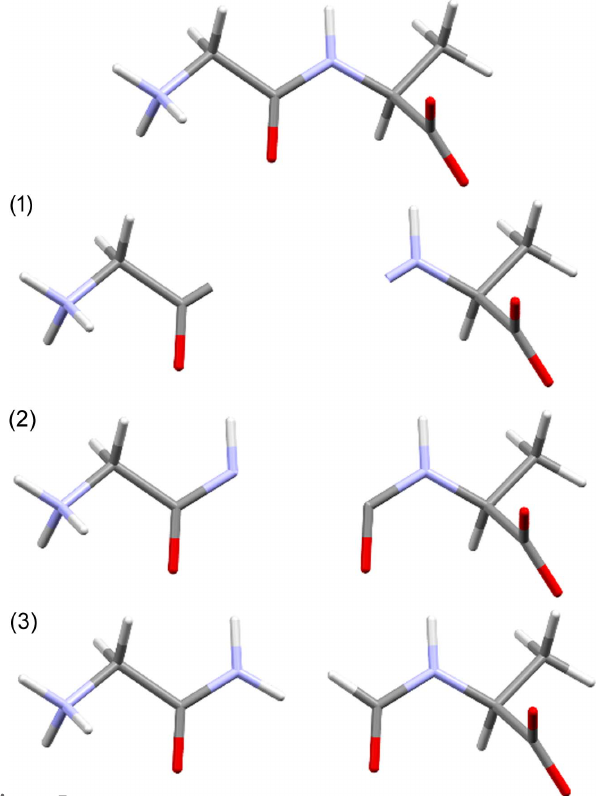
Figure 5 Fragmentation steps: (1) divide a system into separate subunits, (2) extend the subunits so they overlap and (3) add capping hydrogen atoms.